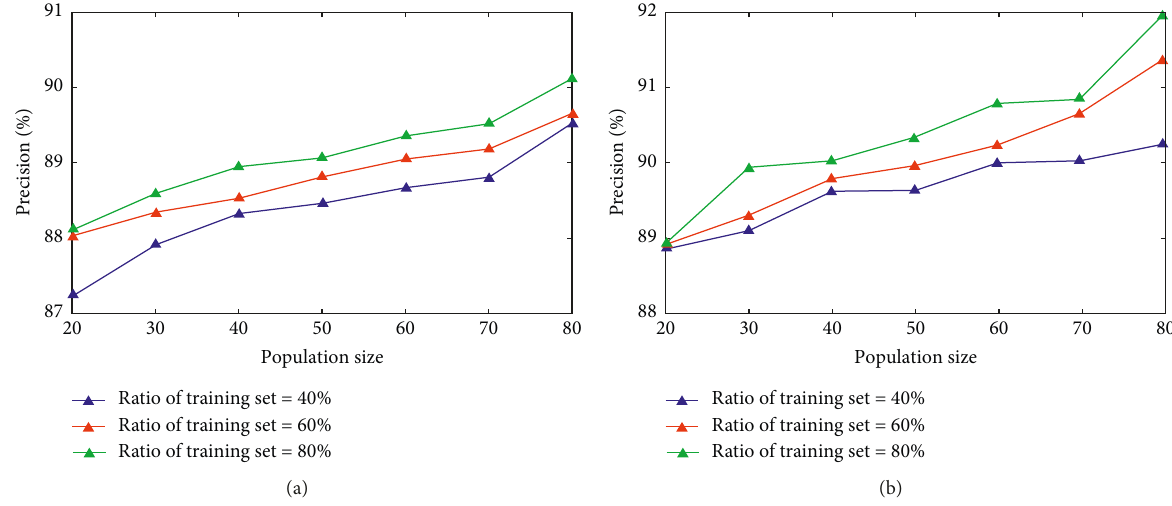
Figure 14: Prediction precision versus population size of QPSO. (a) Ratio of training set � 40%, 60%, and 80%; (b) ratio of training set � 30%, 50%, and 70%.